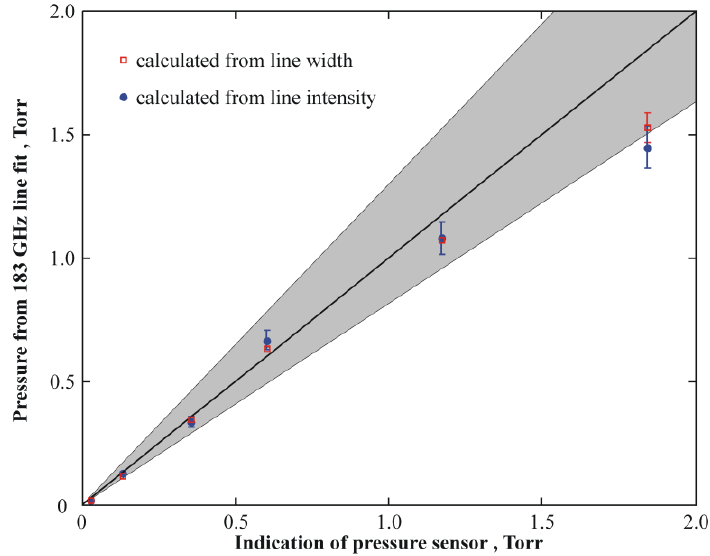
Figure 9. Experimentally determined water vapor pressure as a function of the vacuum gauge readings. The data are obtained using the spectroscopic method. The grey area shows a possible deviation of the real pressure from the readings of the vacuum gauge with the gauge error taken into account.